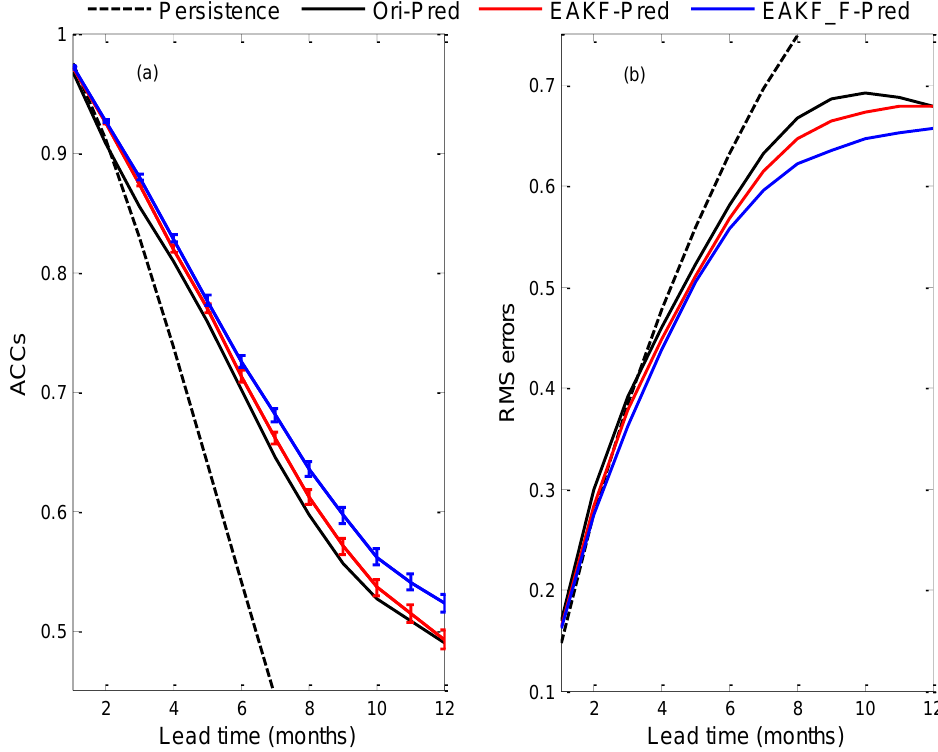
Figure 9. ( a ) ACCs and ( b ) RMS errors between observed and forecasted Niño3.4 SST anomalies with respect to the leading months in persistent prediction and three prediction experiments.